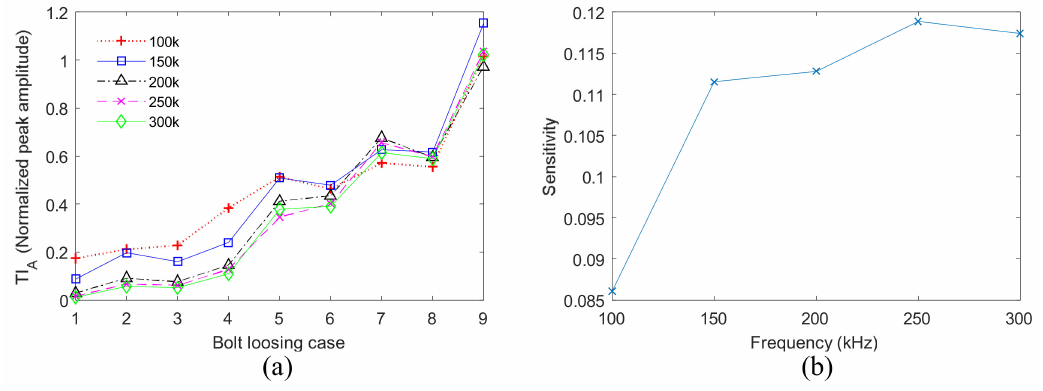
Figure 13. The effect of frequency on TR method ( a ) results using different frequencies; ( b ) detection